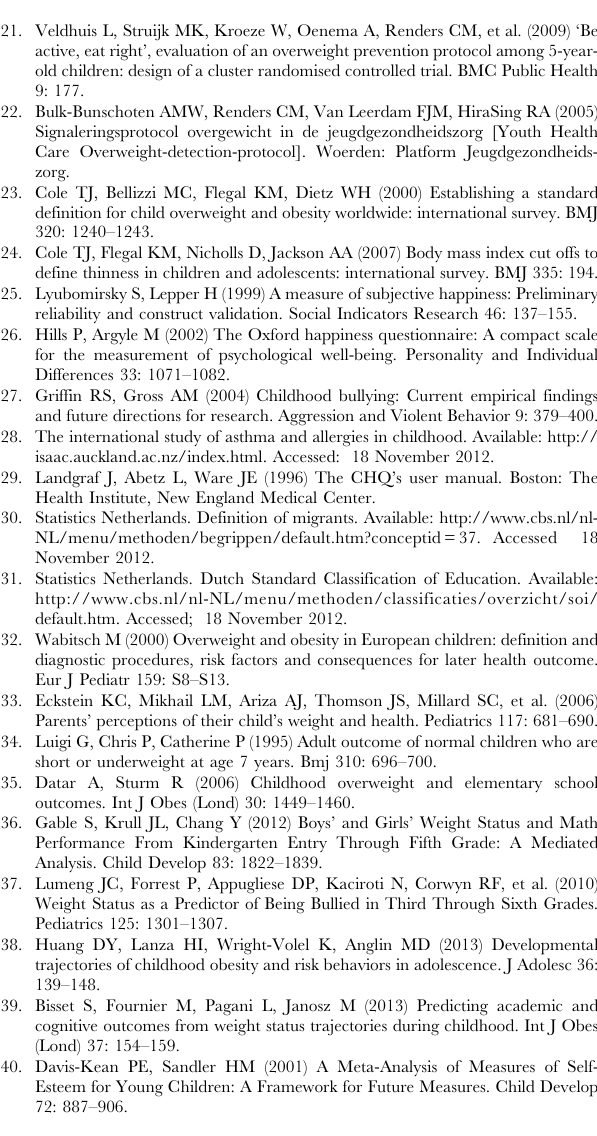
Figure S1 Flow chart of the data selection process. Table S1 Baseline percentages of children visiting the GP and children experiencing certain health conditions; parent report. Table S2 Results of stratified regression analyses predicting health outcomes at age 7 years with BMI-status at age 5 years as